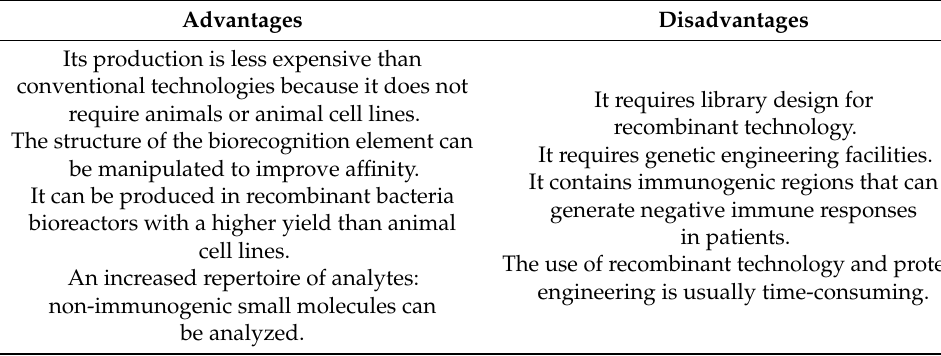
Table 4. Advantages and disadvantages of recombinant antibodies